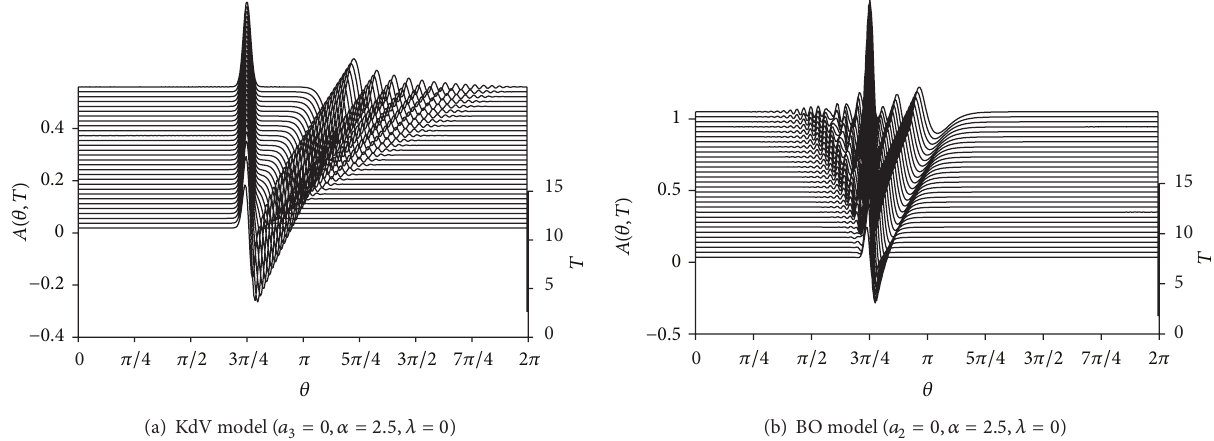
Figure 3: Comparison of KdV model, Bo model, and KdV-BO